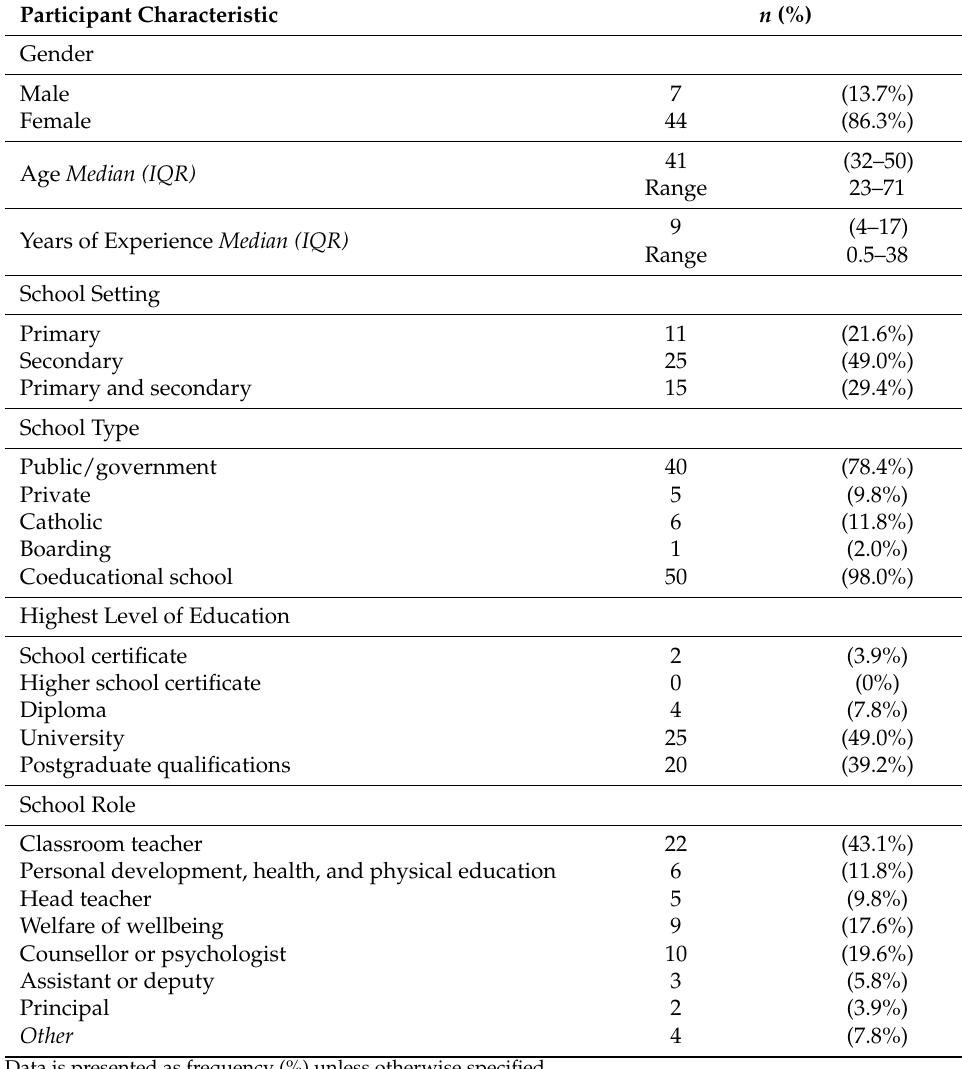
Table 1. Participant characteristics of regional Australian school professionals who completed the online needs assessment survey presented as frequency (%) ( n = 51).